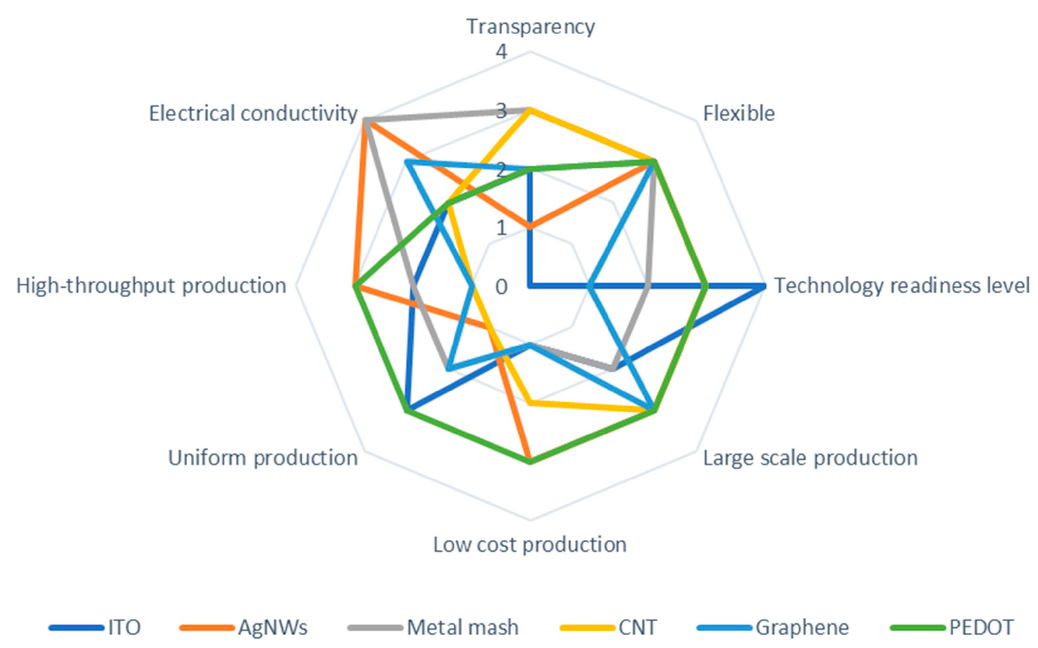
Figure 9. Radar map of different material properties.